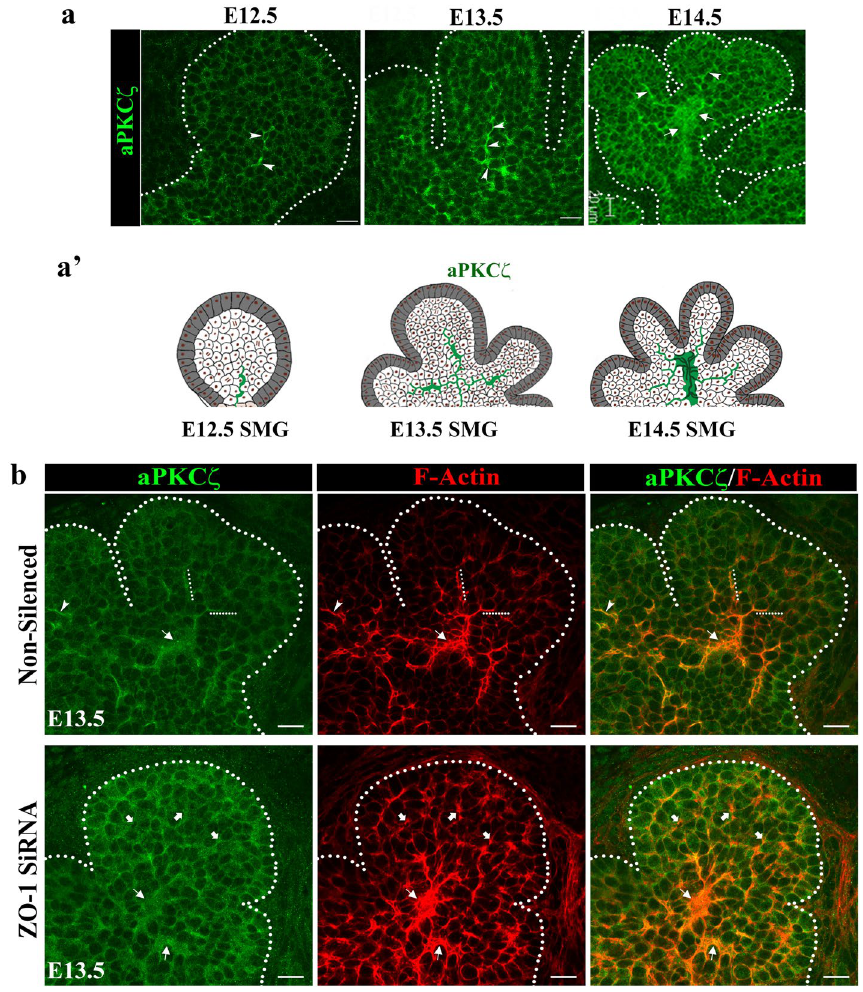
Figure 5. A polarity protein aPKCζ is recruited to the sites of asymmetry in the developing ducts in a ZO-1-dependent manner. ( a ) Immunofluorescence imaging of aPKCζ at progressive stages of branching morphogenesis from the single bud stage at E12.5 to a more elaborate multi-budded structure at E14.5. Arrows ( → ) point to initial enriched localization at single membrane domains marking future ductal extensions at E12.5, followed by a prominent distribution of aPKCζ to the sites of cellular asymmetry along the ductal paths that extend into the newly formed buds at E13.5. There was a further enhancement of aPKCζ in the developing duct regions that had acquired multi-cellular organization in E14.5 SMGs, as well as at the single membrane domains marking extending ductal paths into the newly forming buds ( → ). ( a’ ) Schematic series representing contributions of aPKCζ to the developing ductal paths at different stages of branching morphogenesis. ( b ) Inhibition of ZO-1 expression with siRNA at E13.5 for 24 h resulted in the loss of F-actin-demarcated ductal extensions compared to the non-silenced controls ( → ). Instead, F-actin was bundled in the proximal regions of the newly formed buds with and apparent loss of cells enriched in aPKCζ at the sites of asymmetry ( → ). Size bars, 20 µm. Results are representative of 5 independent experiments (n =